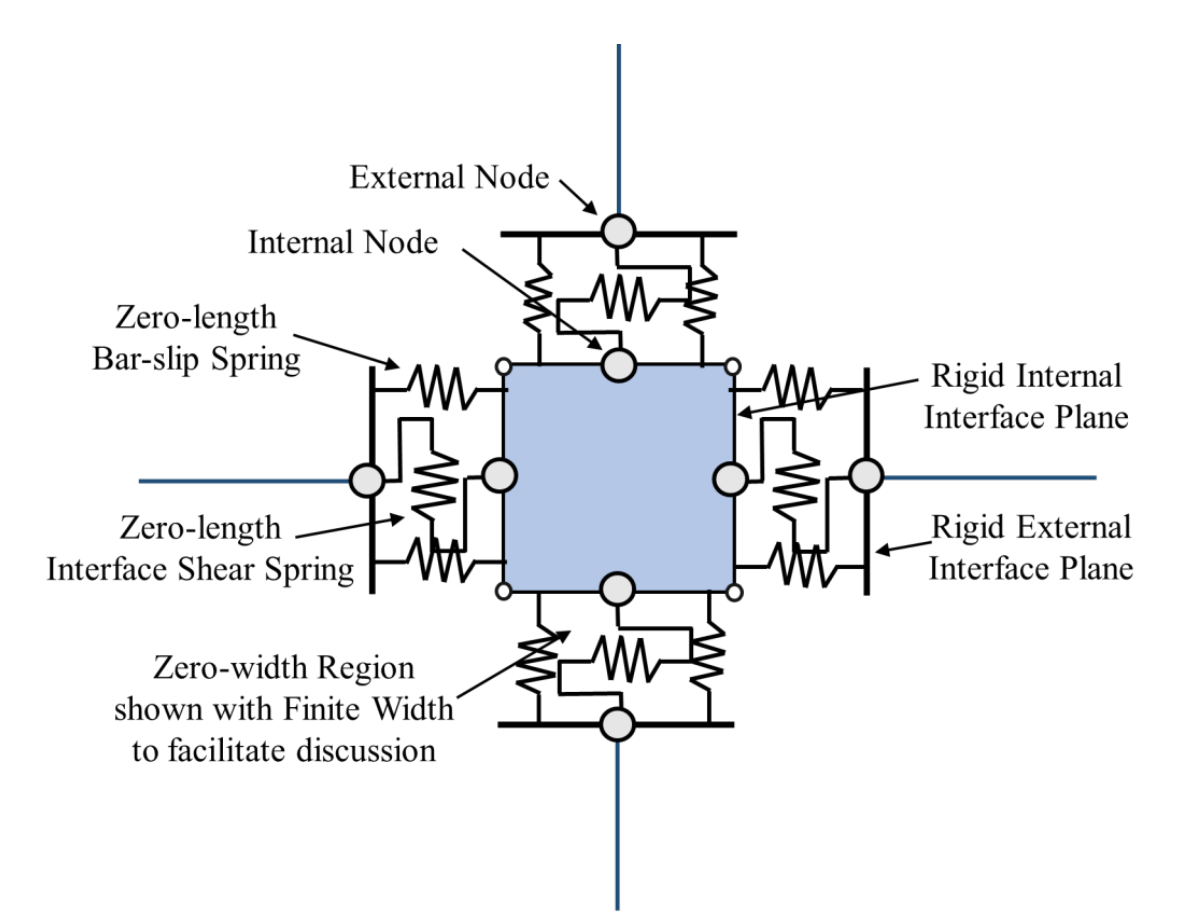
Figure 11. Joint super-element with zero-length interface bar–slip springs placed at the centroid of flexural steel, reproduced from literature [71].